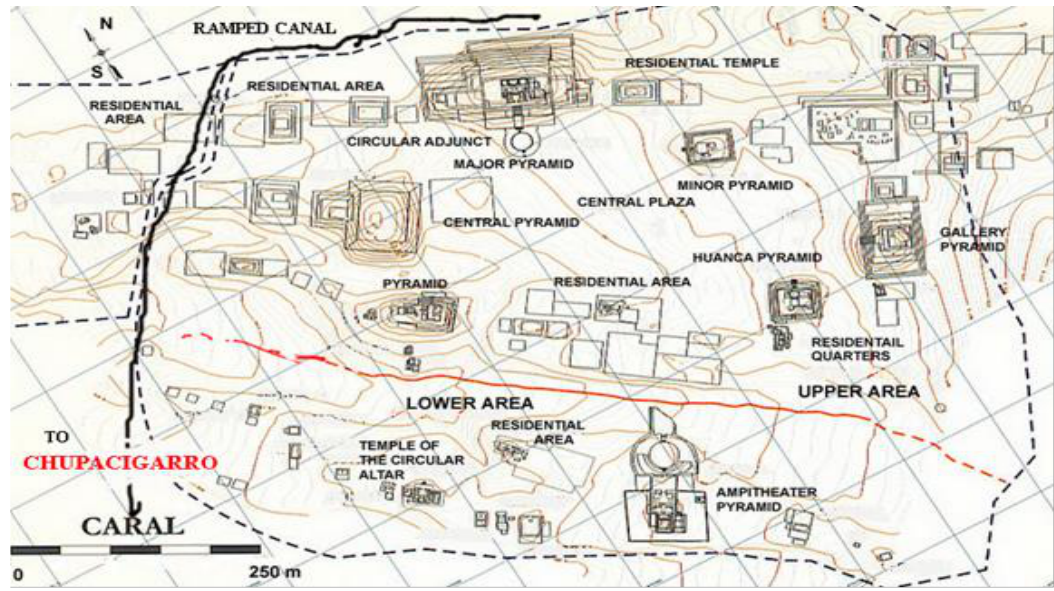
Figure 23. Details of the Caral urban center. Color version of figure derived from [2], p. 225.